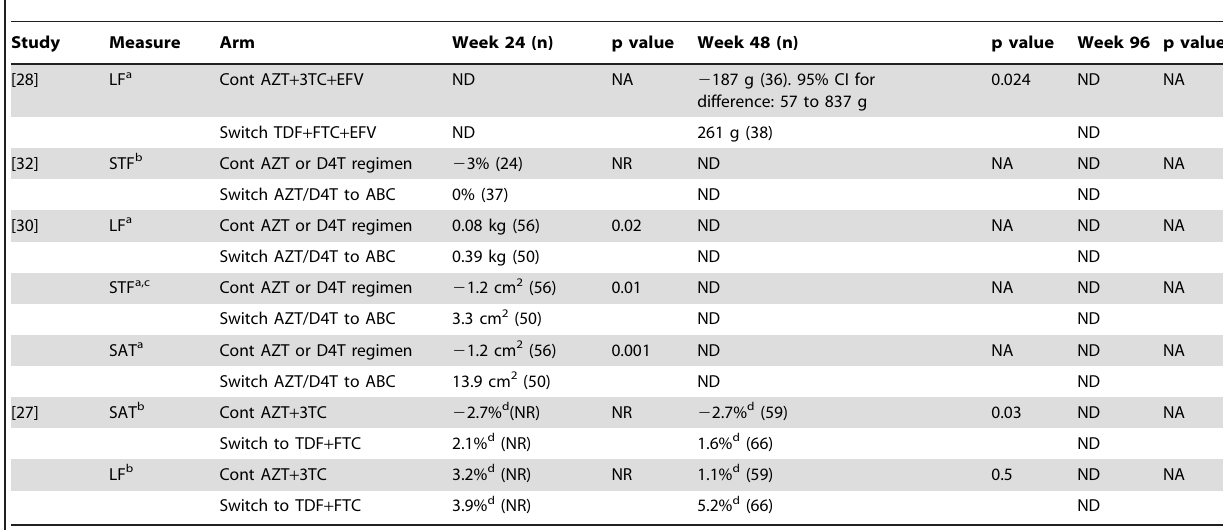
Table 19. Switching studies: change from baseline in limb fat (LF) on DEXA scan, and subcutaneous thigh fat (STF) and subcutaneous adipose tissue (SAT) on CT scan: NRTI versus NRTI.